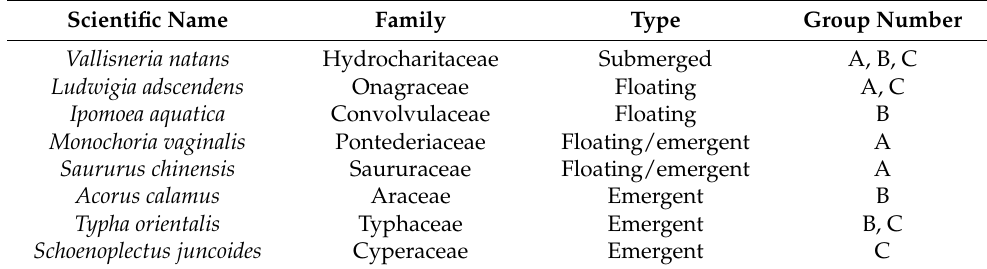
Table 1. Aquatic plant species selected in this